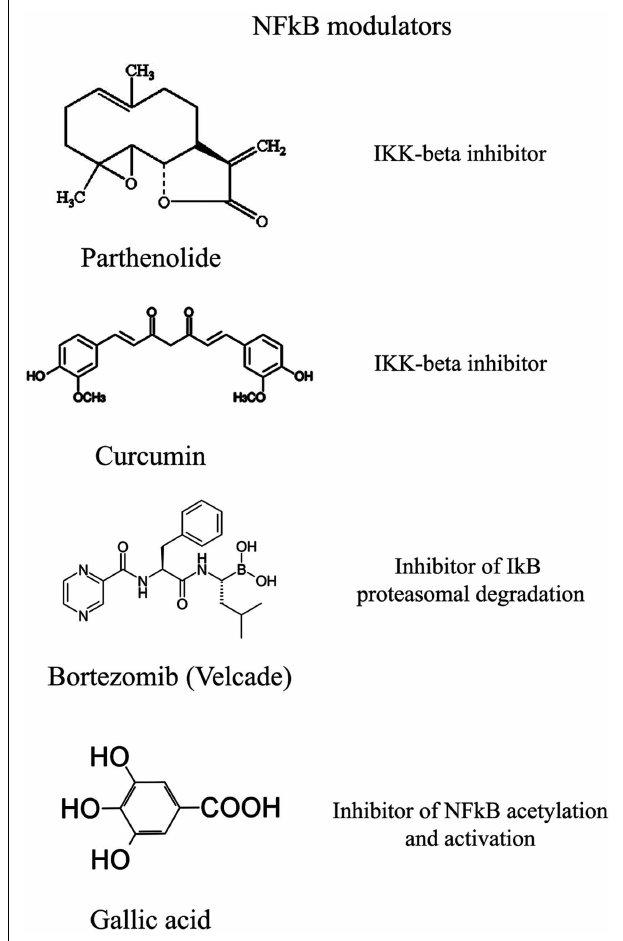
FIGURE 5 | Selection of compounds that can be used to modulate NFkB pathway.